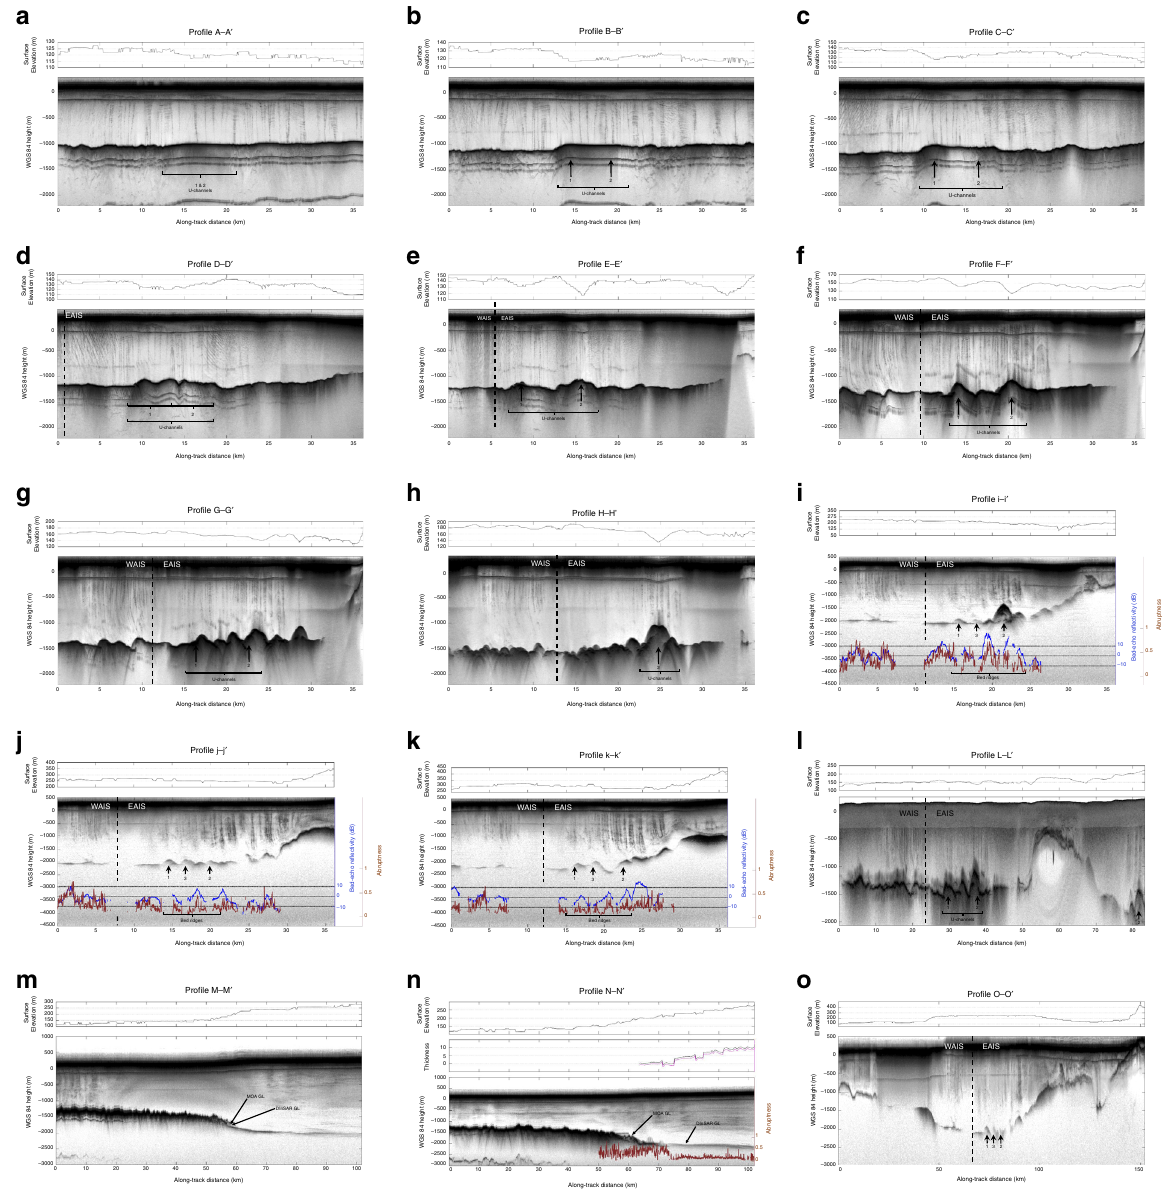
Fig. 2 Radar transects revealing subglacial landforms in grounded ice and basal channels incised upwards beneath fl oating ice. a A – A ’ , b B – B ’ , d C – C ’ , d D – D ’ , e E – E ’ , f F – F ’ , g G – G ’ , h H – H ’ , i i-i', j j-j', k k-k', l L – L ’ , m M – M ’ , n N – N ’ , and o O – O ’ , as located in Fig. 1. Extended versions of i-i' (I-I'), j-j' (J-J') and k-k' (K-K') can be found in Supplementary Figure 2. Also for these three transects, basal re fl ectivity (relative values, zero mean) and the echo abruptness are provided. For transect N – N ’ , the echo abruptness is provided (revealing a step change between grounded and fl oating ice) with the thickness of ice above the level of fl otation (with a tidal range of 0 m, black line; and + 5 m, pink line). The identi fi cation of three fl ow-parallel bedforms and U-channels, described in Supplementary Figure 5, are also shown (see Supplementary Figure 6 for locations). Separation between ice sourced from East versus West Antarctica is noted by the dashed black line. Surface elevation pro fi les (from the aircraft altimeter) are also